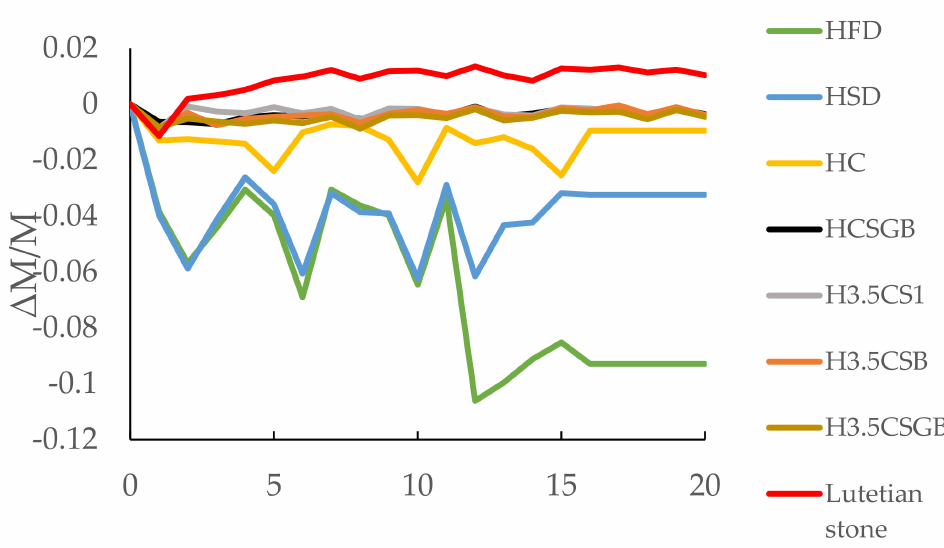
Figure 4. Experimental results from the freeze and thaw cycles